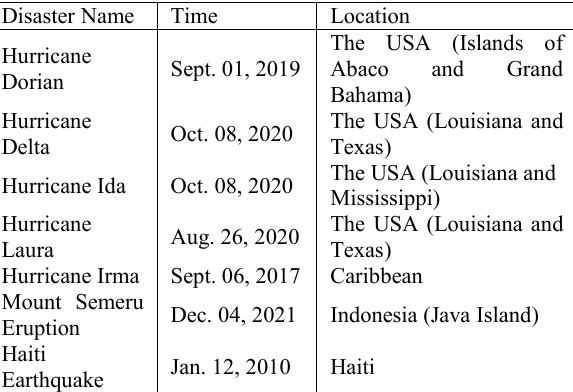
Table 2 . Disaster list of collecting